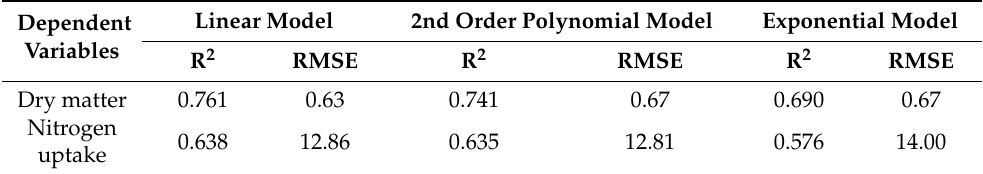
Table 5. Values of R 2 and RMSE by general approach using linear and non-linear regression.